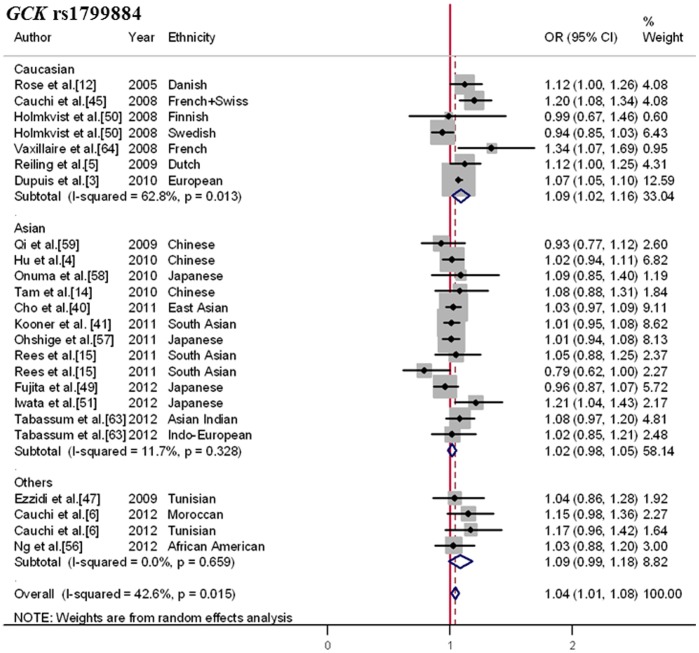
Forest plot for the association between GCK rs1799884 and T2DM.Pooled OR for the additive genetic model was shown under a random-effects model. Square sizes were proportional to weight of each study in the meta-analysis. Significant association was detected in Caucasians but not in Asians and others.